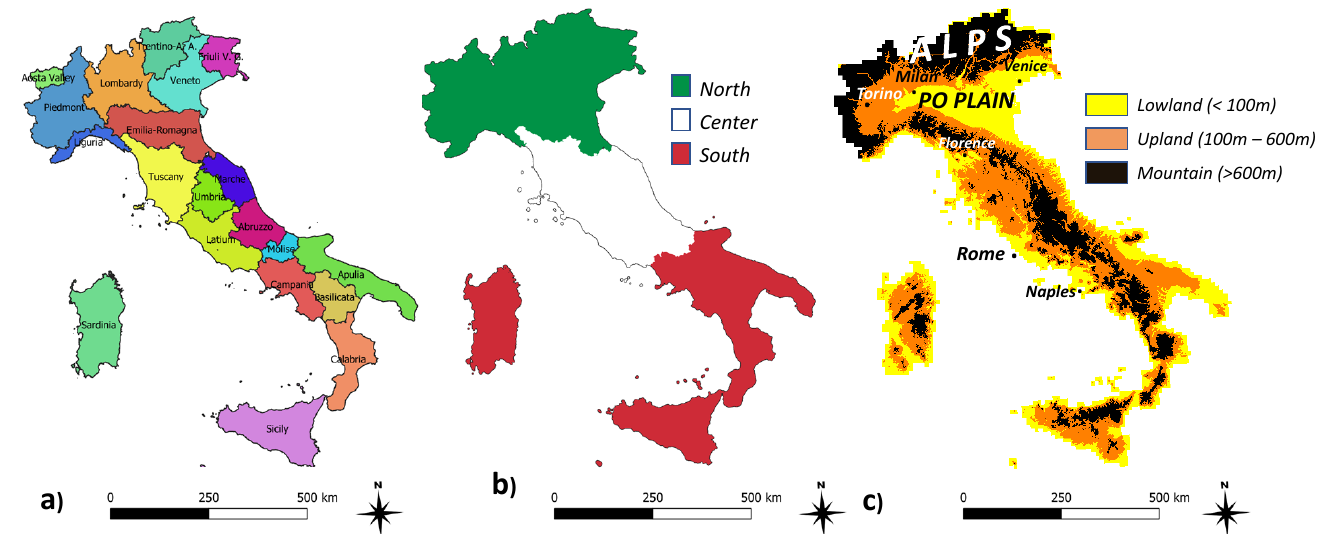
Figure 1. Partitions of Italy into: ( a ) 20 administrative regions according to nomenclature of territorial units for statistics (NUTS-2); ( b ) latitudinal belts; ( c ) elevation classes. Four indicators, containing information on land quality in terms of climate (climate quality index, CQI), soil (soil quality index, SQI), vegetation (vegetation quality index, VQI), and land management (land management quality index, MQI), were computed as the geometric mean of the different scores for each variable [82]. The scores of the ESAI ranged between 1 (the lowest vulnerability level) and 2 (the highest vulnerability